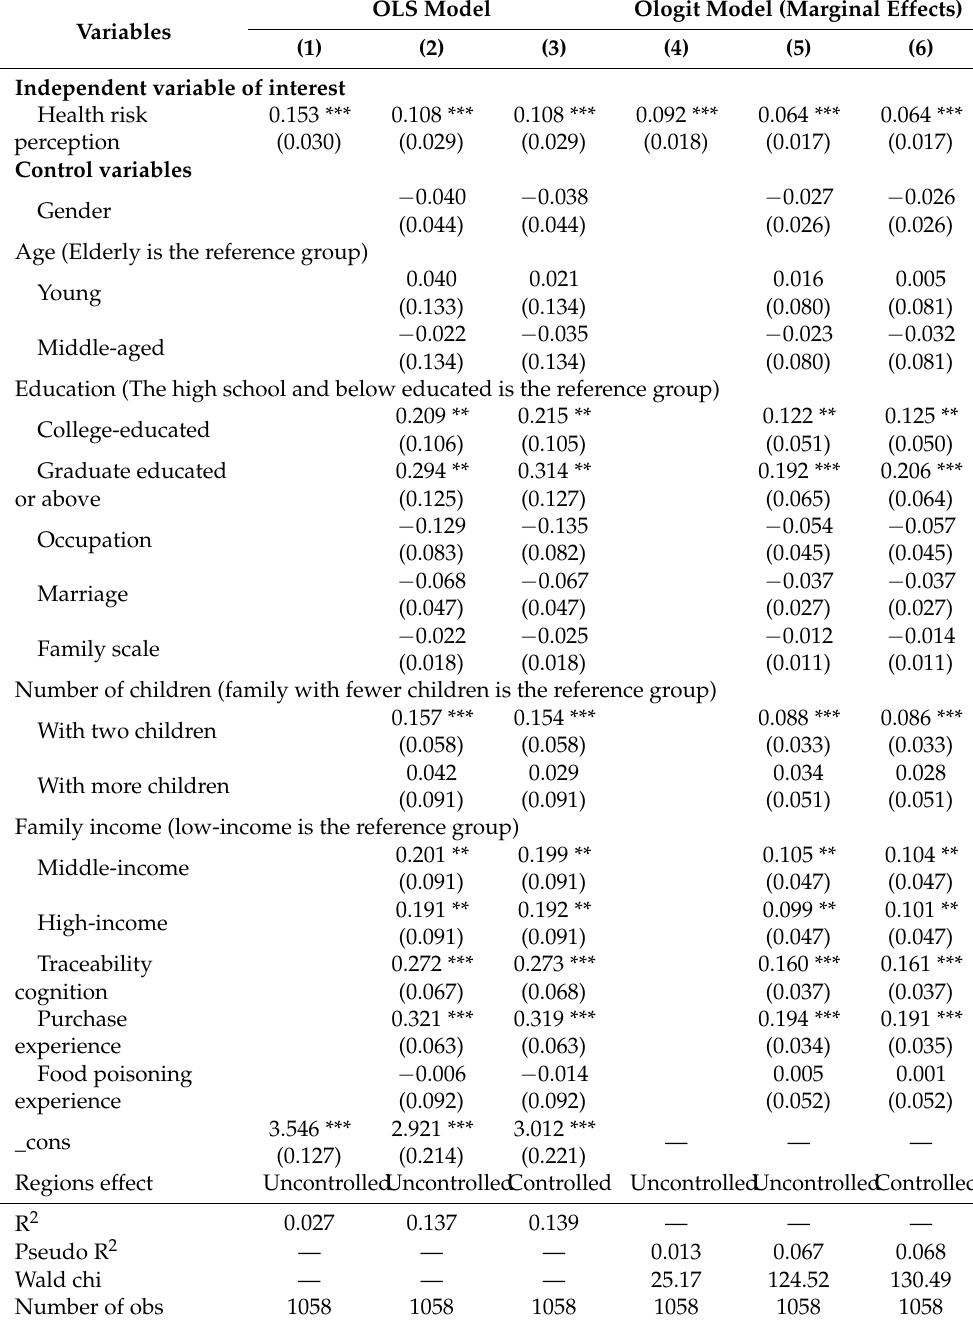
Table 2. Impact of health risk perception on purchase